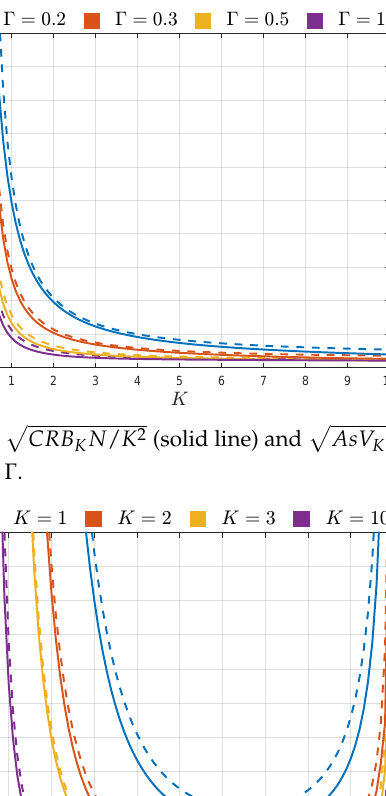
(cid:112) CRB Γ N / Γ 2 (solid line) and Figure 5. values of K